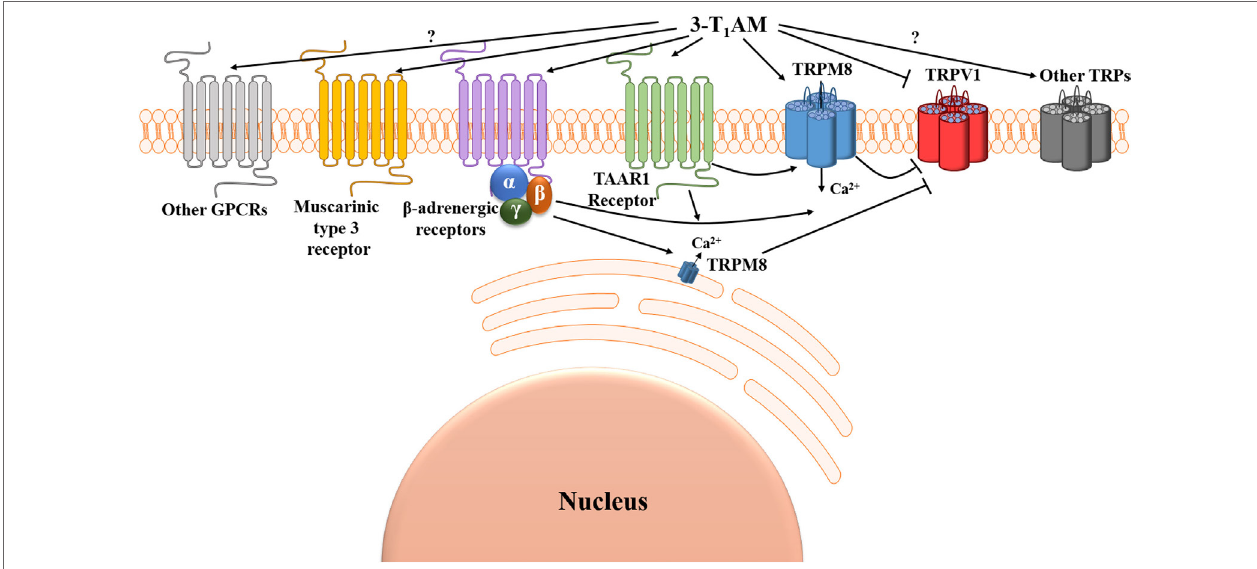
FigURe 1 | Suggested Ca 2 + signal transduction pathways induced by 3-iodothyronamine (3-T 1 AM). Two G protein-coupled receptors (GPCRs), known as trace amine-associated receptor 1 (TAAR1) and β -adrenergic receptors, can be activated and one GPCR known as muscarinic type 3 receptor can be suppressed by 3-T 1 AM. 3-T 1 AM increases [Ca 2 + ] i via a member of the transient receptor channel superfamily known as transient receptor potential channel melastatin 8 (TRPM8) (menthol or cold receptor), and this effect is blocked by BCTC. 3-T 1 AM may either directly activate TRPM8 by a GPCR-independent mechanism or indirectly via the β / γ -subunits of Gi/o downstream of β -adrenergic receptors. TRPM8 activation by 3-T 1 AM inhibits TRPV1 (capsaicin or heat receptor)-induced Ca 2 + influx. Notably,